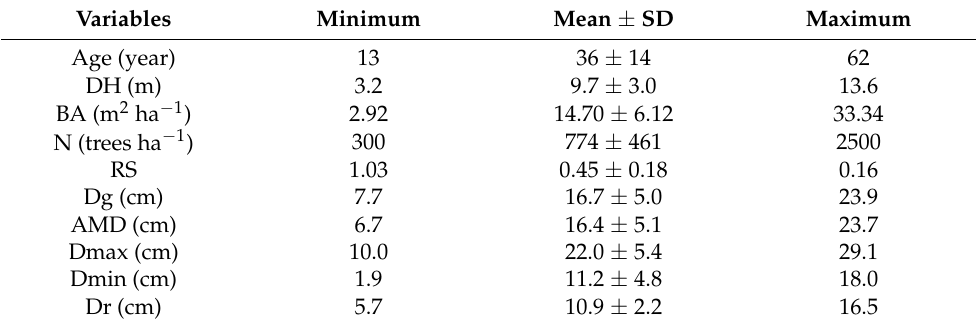
Table 2. Summary statistics of evaluated stand-level predictor